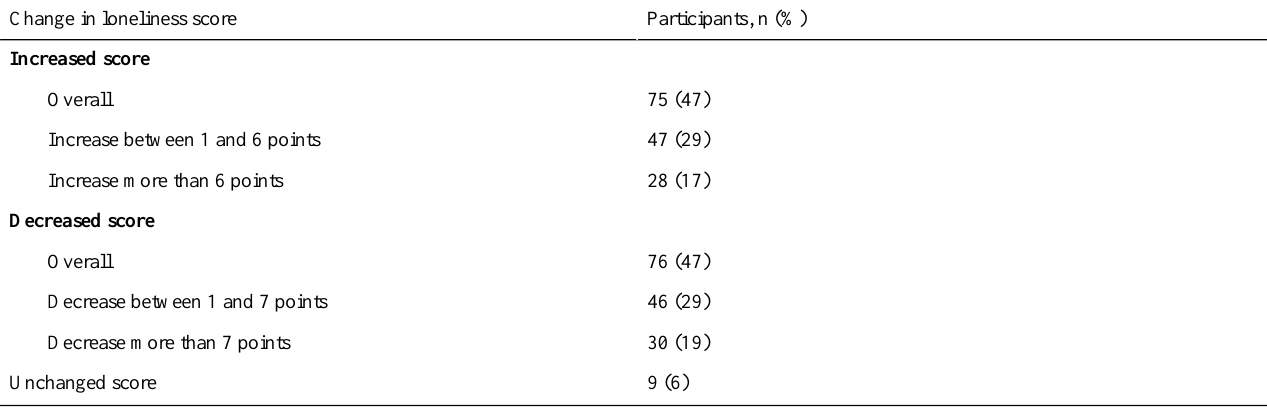
Table 3. Statistics of change in loneliness scores measured by University of California, Los Angeles, scale in pre- and postsurveys